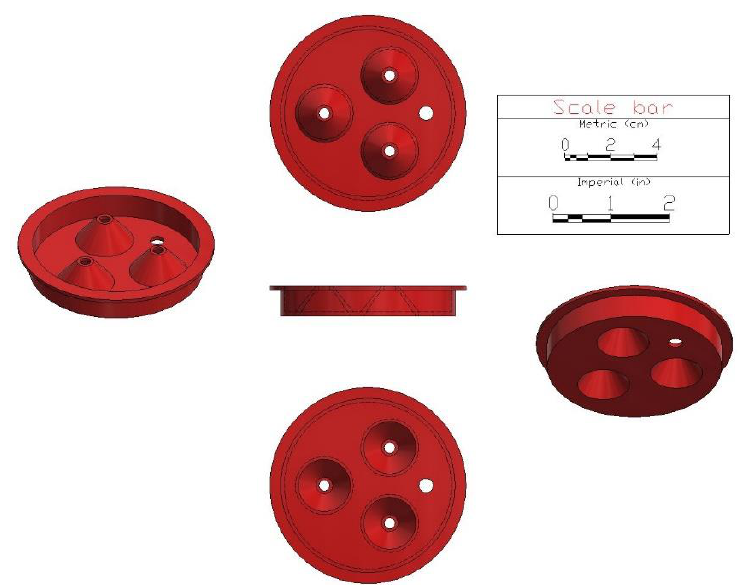
( d ) Figure 1. ( a ) The complete soil column system composed of three components: ( b ) the soil column, ( c ) the soil column stand, ( d ) the soil column mist nozzle and piping. 2.1. Design of Flow-Reduction Cap The flow-reduction cap (Figure 2; Table 1) is a barrier that sits between the mist nozzle housing and coupling spacer within the coupling in the soil column (Figure 3). It was designed in Autodesk ® (San Rafael, CA, USA) Inventor ® and 3D-printed on an Ultimaker 2+ 3D-printer with acrylonitrile